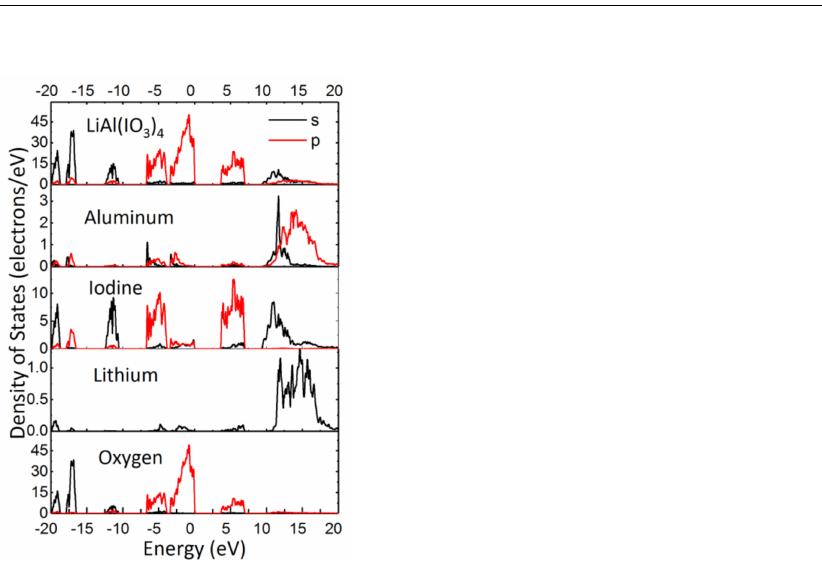
Figure 8. Calculated total distribution of states (DOS) of LiAl(IO 3 ) 4 (top), and partial DOS due to aluminum, iodine, and oxygen atoms in the LiAl(IO 3 ) 4 structure. Black lines: contribution of s states; red lines: contribution of p states. The calculations were performed using the PBE + scissor method.